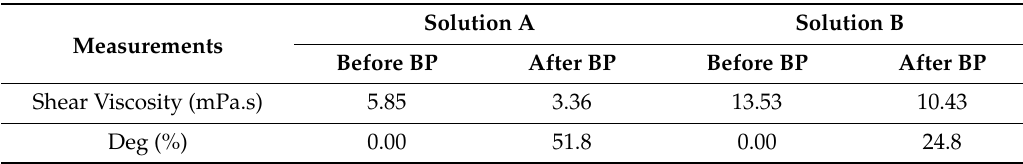
Table 3. Effect of backpressure regulator on shear viscosity of Solutions A and B. Shear viscosity . γ measured at = 10 s − 1 .